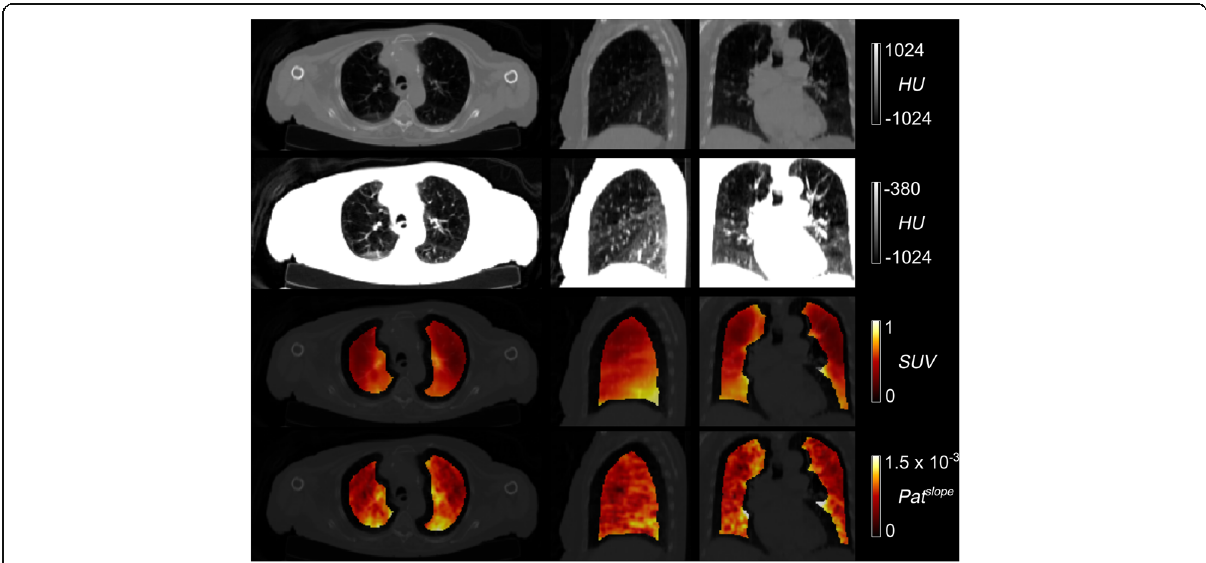
Fig. 2 Axial ( left ), coronal ( middle ) and sagittal ( right ) slices for the CT-AC (first and second row) and the averaged (30 – 60 min) SUV ( third row ) and Pat slope (fourth row) parametric images of a representative COPD patient (M, 66 years). The axial slice was chosen in the upper part of the lung as being representative of tissue loss in COPD. CT-AC : computed tomography attenuation correction, SUV : standardised uptake